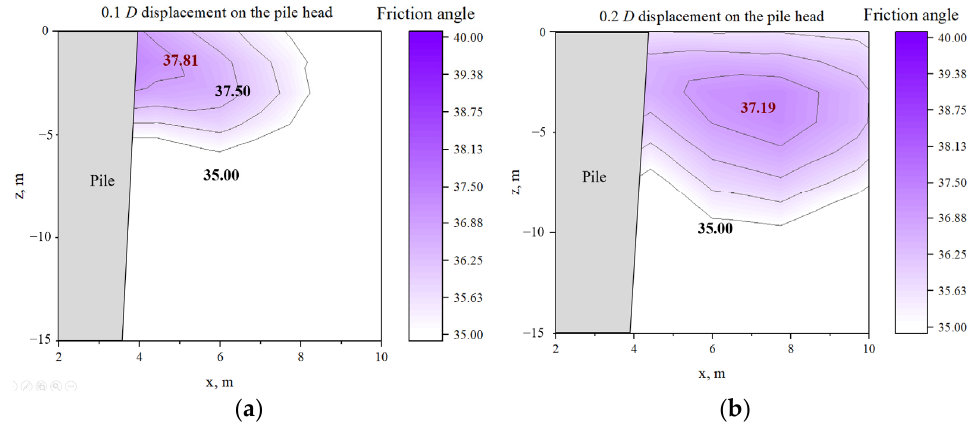
Figure 12. The friction angle contour at the pile head displacement of ( a ) 0.1 𝐷 ; ( b ) 0.2 𝐷 in local scour condition.